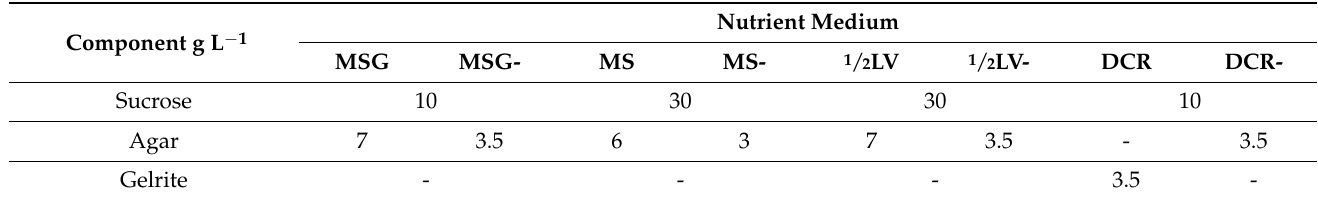
Table 2. The content of gelling agent and sucrose in different types of nutrient